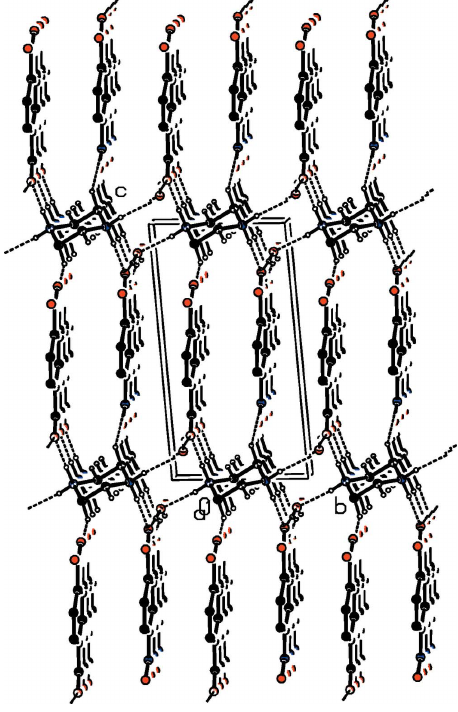
Figure 2 A view along the a axis of the crystal packing of the title compound. Hydrogen bonds (Table 1) are shown as dashed lines, and H atoms not involved in these interactions have been omitted for clarity.